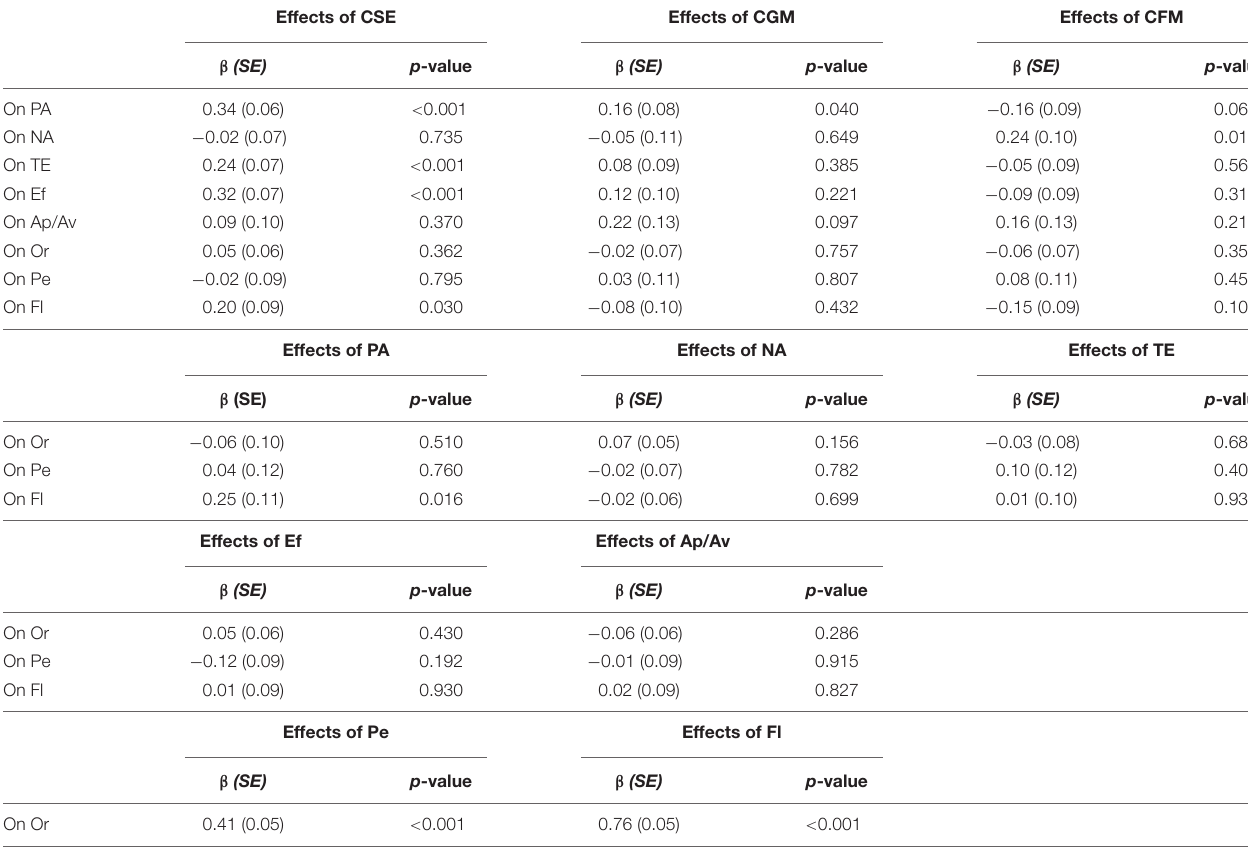
TABLE 2 | Direct effects of Model